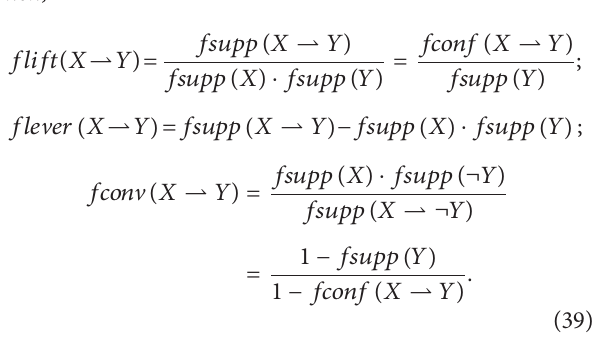
Table 2: Comparison of lift, leverage, and conviction computed with different 𝑡 -norms on stochastically independent data generated randomly from uniform